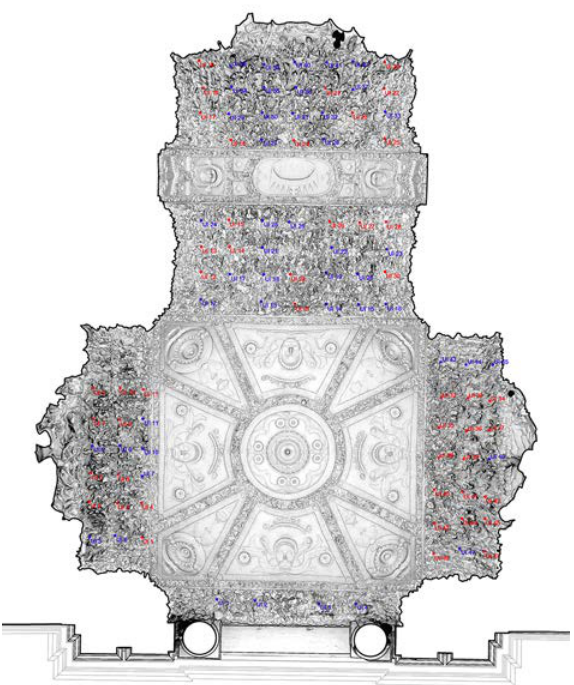
Figure 2. The vault with the position of the